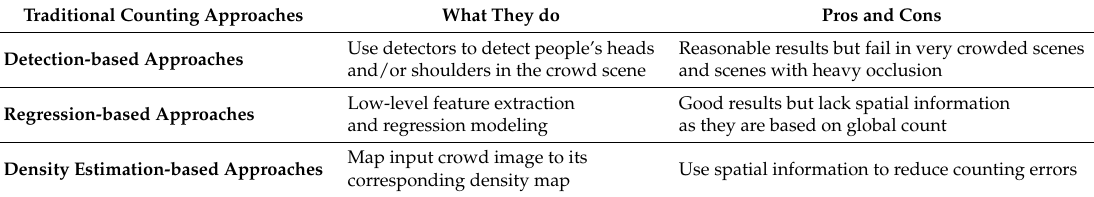
Table 1. Traditional Counting Approaches Comparison.